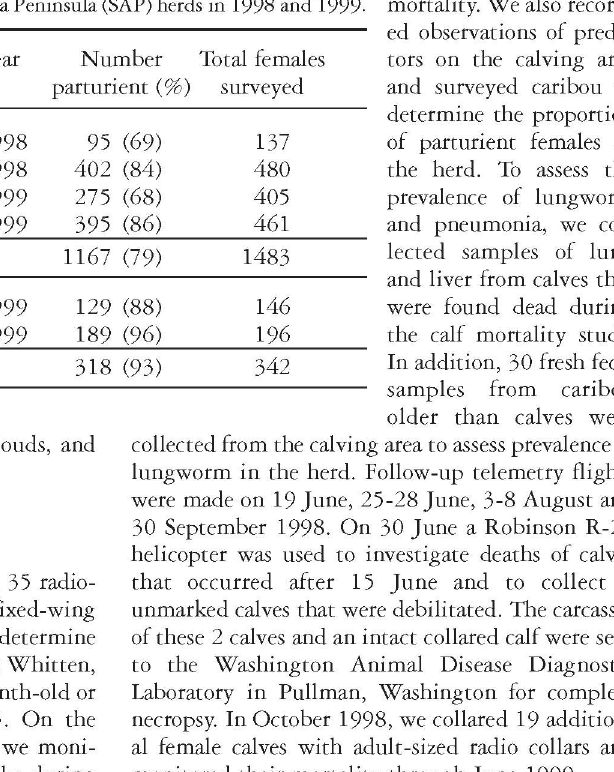
Table 1. Natality of females surveyed on the calving areas of the Northern Alaska Peninsula (NAP) and Southern Alaska Peninsula (SAP) herds in 1998 and 1999. Herd and area Year Total